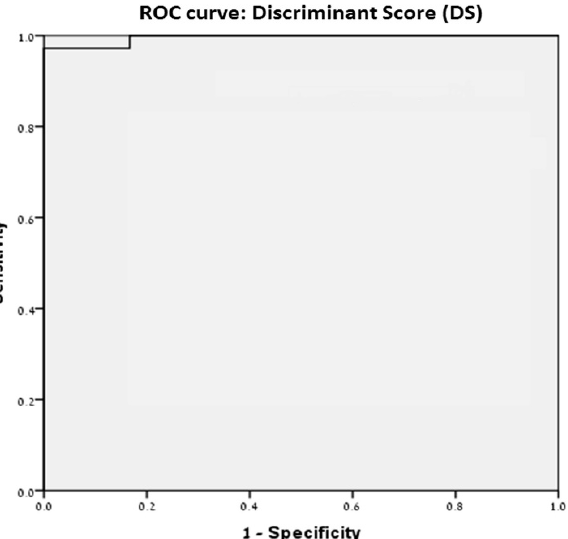
Figure 1. Receiver-operating curve of selected morphometric characteristic. A discriminate score of − 1.1134 can distinguish between low Gleason grade 3 and high Gleason score (4 and 5) with 97.2% sensitivity and 100% specificity.